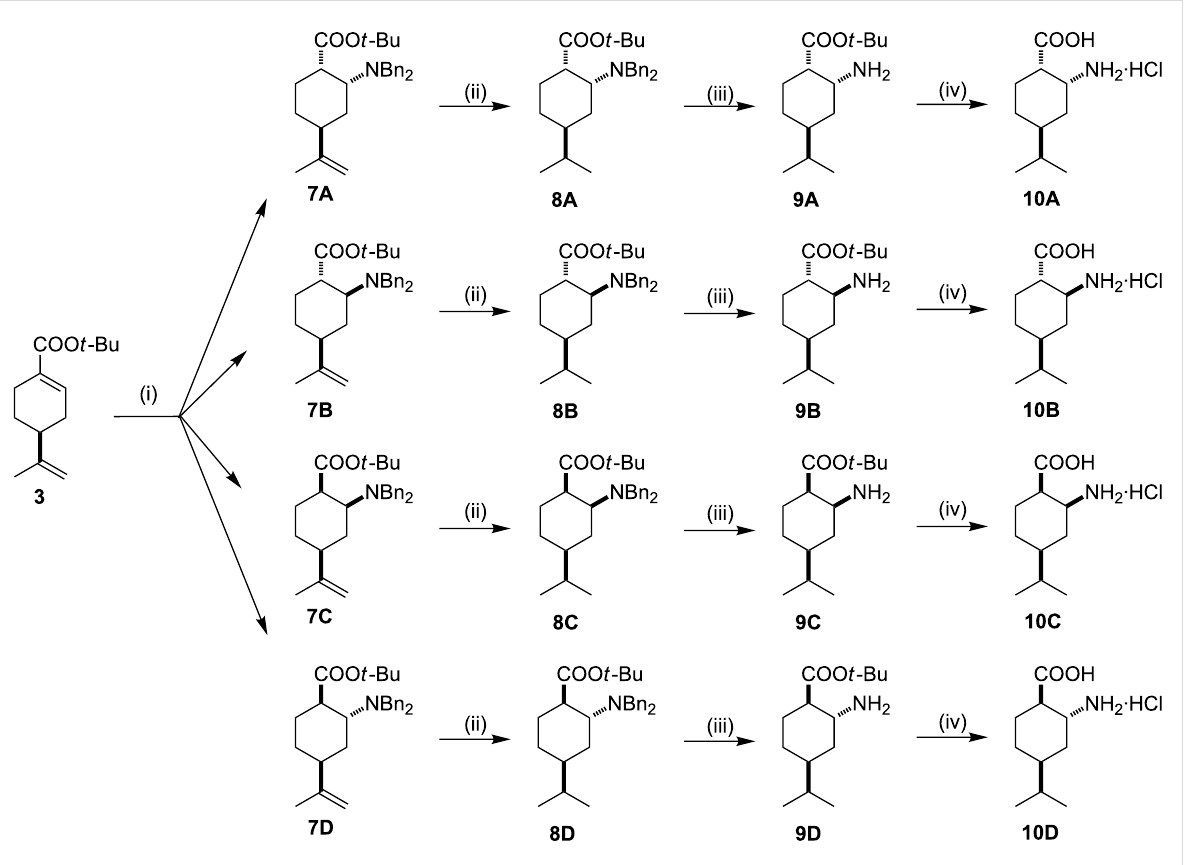
Scheme 2: Reagents and conditions: (i) 2.4 equiv LiNBn 2 , dry THF, − 78 °C, 6 h, then NH 4 Cl (aq), overall yield: 87% (isomeric mixture), ratio 7A : 7B : 7C : 7D = 76:17:6:1; (ii) 5% Pt/C, n -hexane/EtOAc 1:1, 1 atm. H 2 , rt, 16 h, yield: 90–92%; (iii) 5% Pd/C, n -hexane/EtOAc 1:1, 1 atm H 2 , rt, 24 h, yield: 92–95%; (iv) 10% HCl (aq), rt, 24 h, yield: 90–94%.